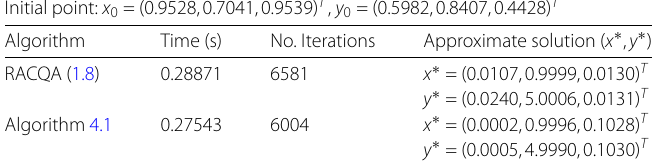
Table 3 Numerical results of Example